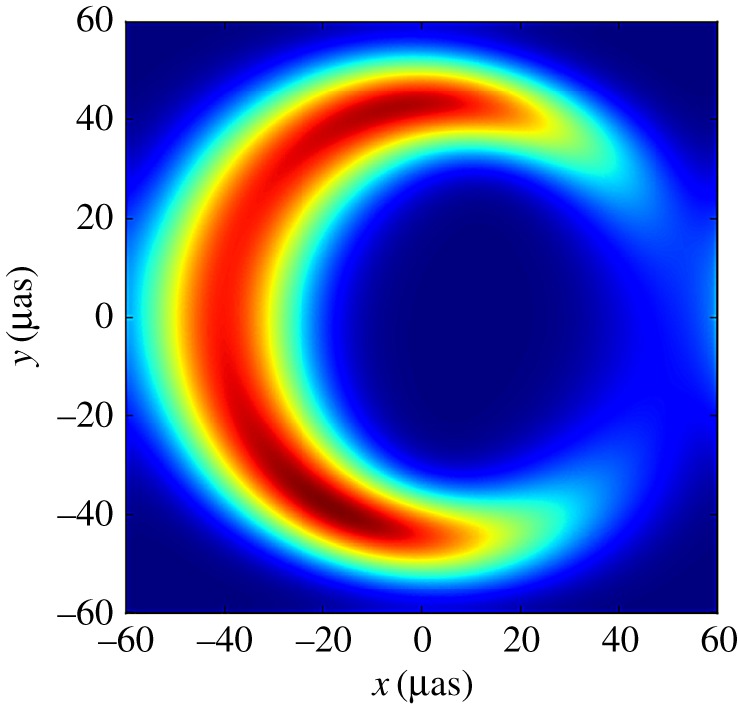
The results from a simple crescent model for the shadow of a black hole, one of a number of models being used to provide a statistical description of the existing EHT observations of Sgr A*. Adapted from Kamruddin & Dexter [228].